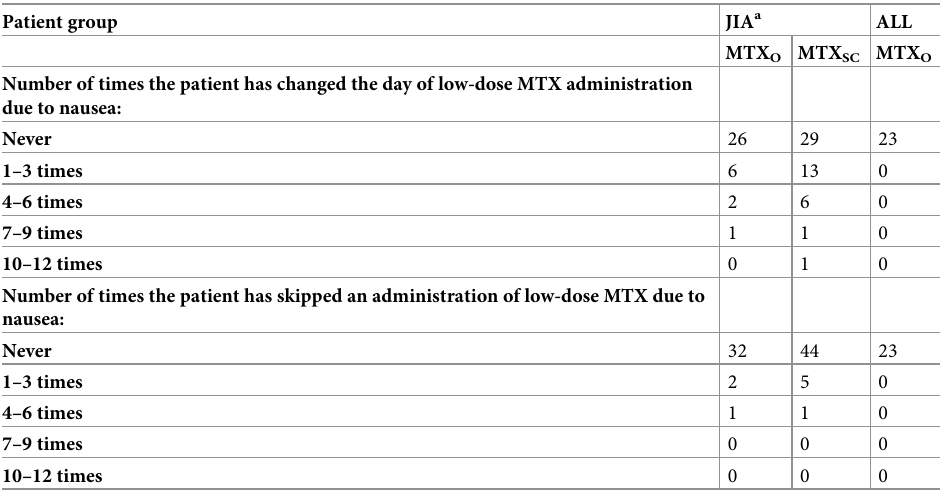
Table 2. Low-dose MTX treatment compliance. Patient group JIA